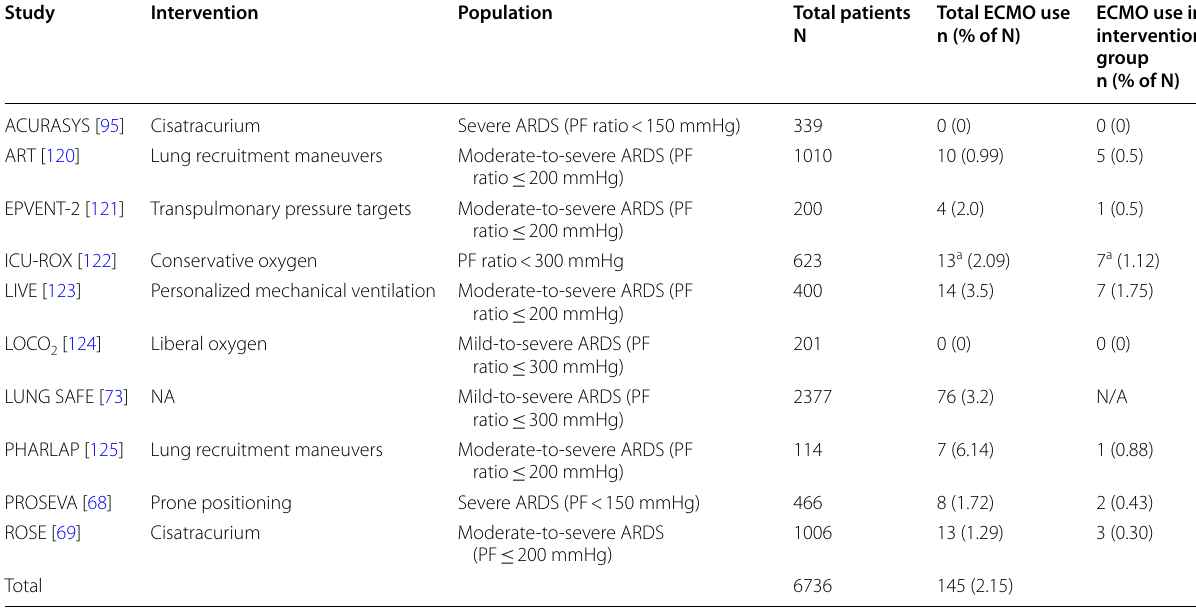
a The number of patients reported (N) reflects the use of extracorporeal membrane oxygenation (ECMO) and extracorporeal carbon dioxide removal (ECCO non-applicable; ARDS, acute respiratory distress syndrome; PF, ratio of partial pressure of oxygen to inspired fraction of oxygen